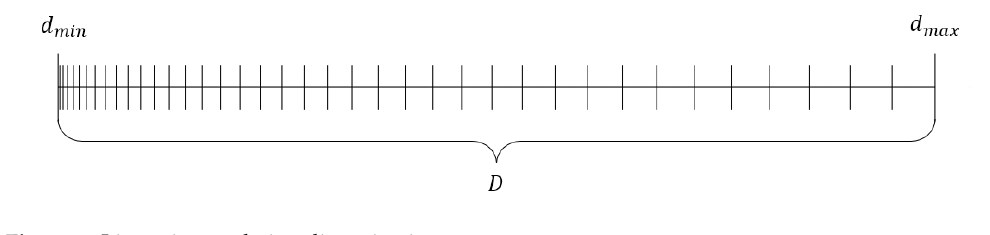
Figure 6. Linear interpolation